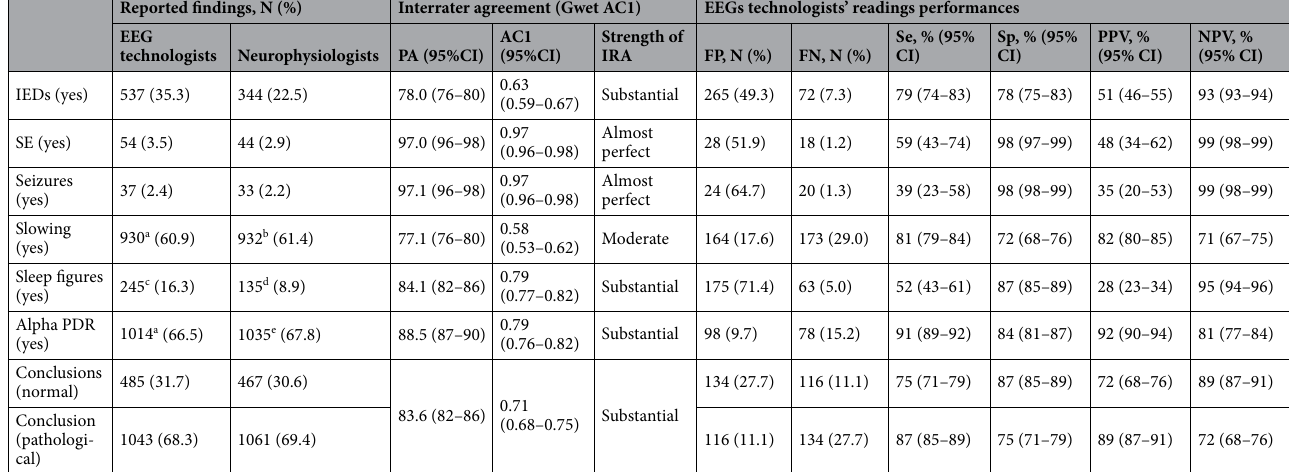
Table 2. Interobserver agreement and EEG technologists’ reading performances regarding the primary EEG features. %FP are expressed as FP/exams coded “yes” for the specified condition by EEG technologist. %FN are expressed as FN/exam coded “no” for the specified condition by EEG technologists. ACI Agreement coefficient, FN false negative, FP false positive, IEDs interictal epileptiform discharges, IRA interrater agreement, PA percentage of agreement, Se sensibility, Sp specificity, NPV negative predictive value, PDR posterior dominant rhythm, PPV positive predictive value, SE status epilepticus. a 2 missing data. b 11 missing data. c 26 missing data. d 18 missing data. e 1 missing data.